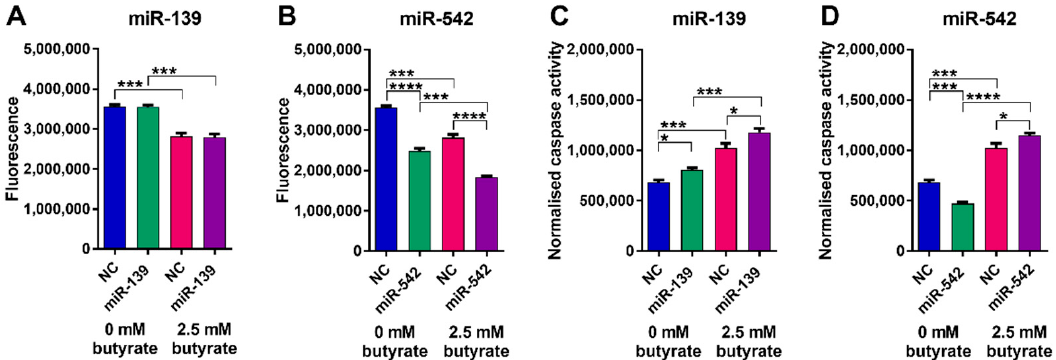
Figure 10. Cell viability and apoptosis in miRNA-transfected LIM1215 cells after 24 h of butyrate treatment. ApoLive-Glo™ multiplex assay: fluorescence and luminescent signals for viability changes ( A ) miR-139, ( B ) miR-542 and normalized caspase activity for apoptosis changes, respectively ( C ) miR-139, ( D ) miR-542 in LIM1215 cells transfected with butyrate-sensitizing miRNAs for 48 h, followed by 24 h of treatment with 0 mM or 2.5 mM butyrate, over a 72 h post-transfection period. Significant results are indicated by * p < 0.05, *** p < 0.001, **** p < 0.0001. NC = negative control mimic.